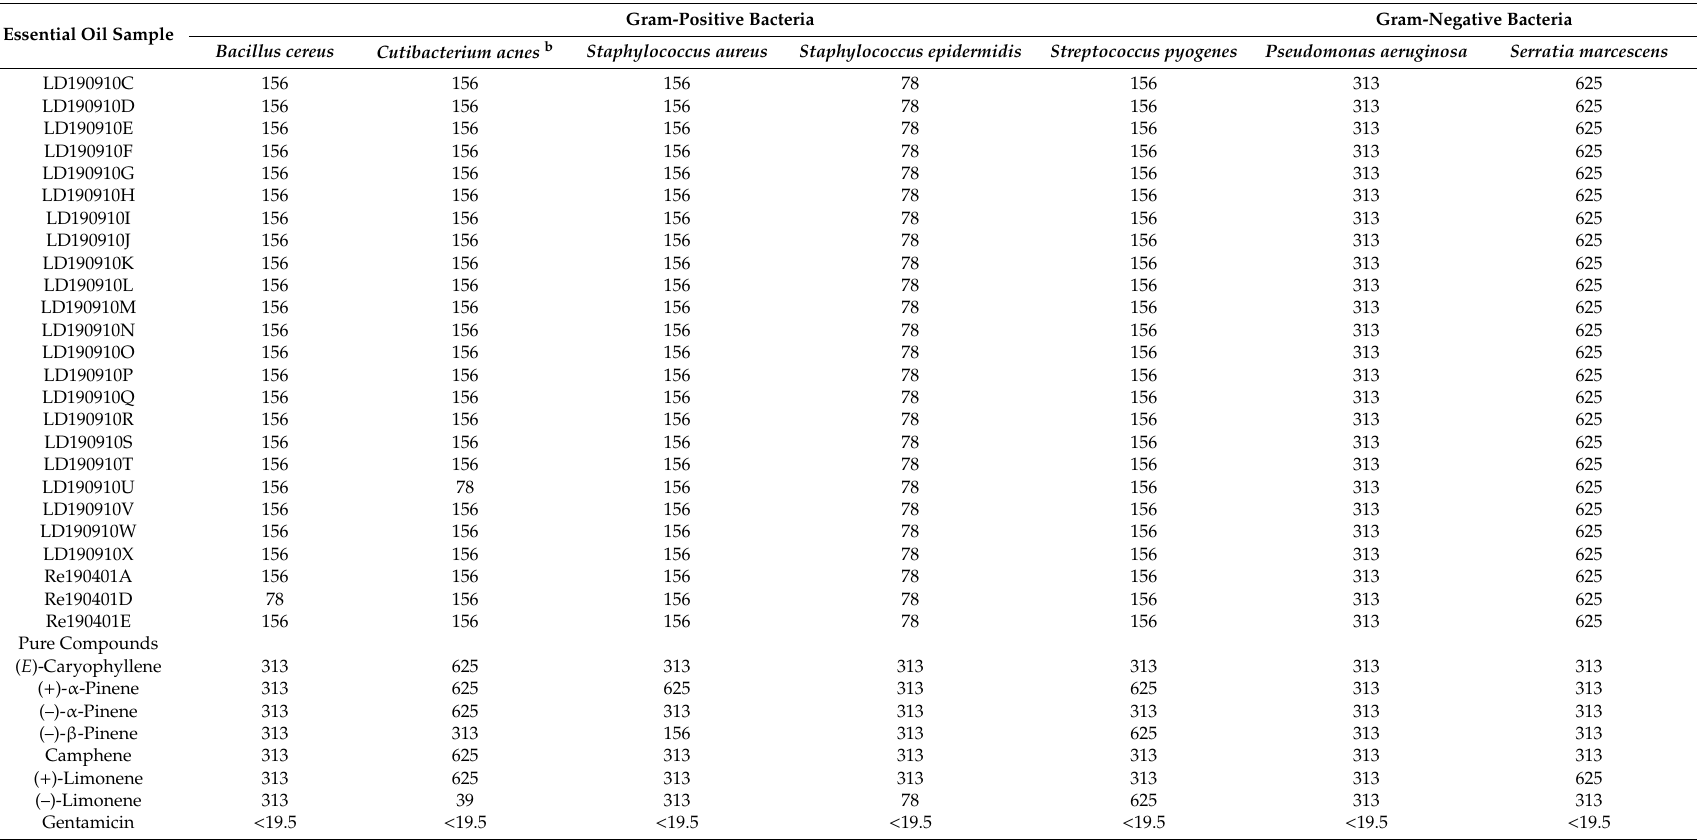
Table 3. Antibacterial activities, MIC a ( µ g / mL), of oleoresin essential oils of Liquidambar formosana and major essential oil